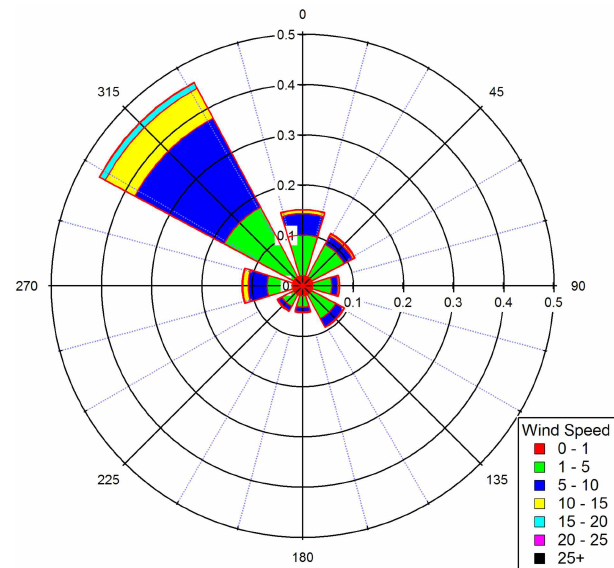
Figure 4. Wind rose plot derived from in situ one minute wind di- rection and wind speed data at the measurement site (30.667 ◦ N, 76.729 ◦ E, 310ma . s . l . ) in May 2012.